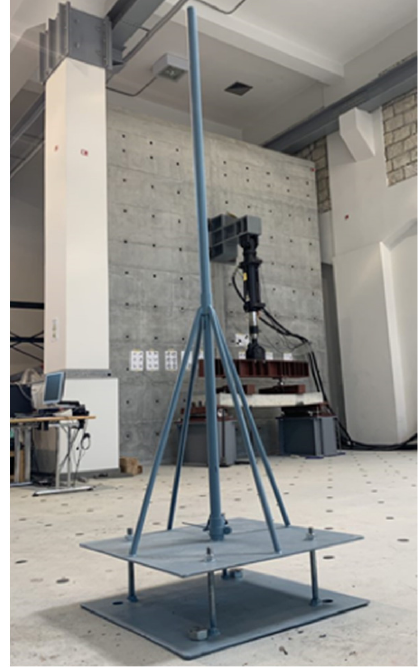
Figure 4. Impact test drop-weight frame.